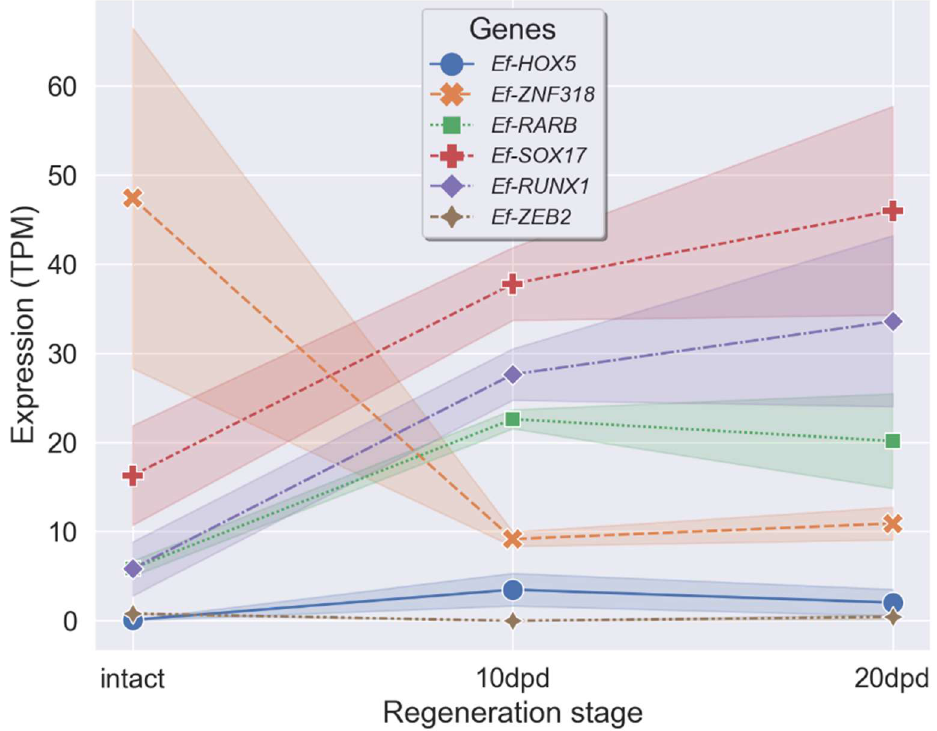
Figure 6. TPM values of the TF genes with significant changes in the expression level compared to the intact sample during the regeneration in E. fraudatrix .